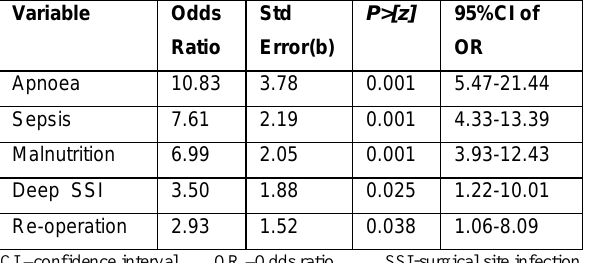
Table 4: Determinants of mortality (binary logistic regression analysis)